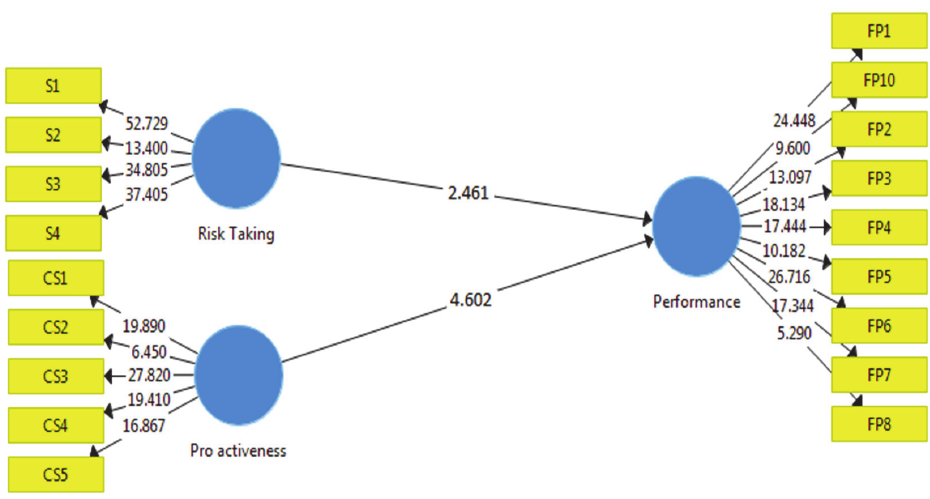
Fig. 2. PLS Bootstrapping Direct